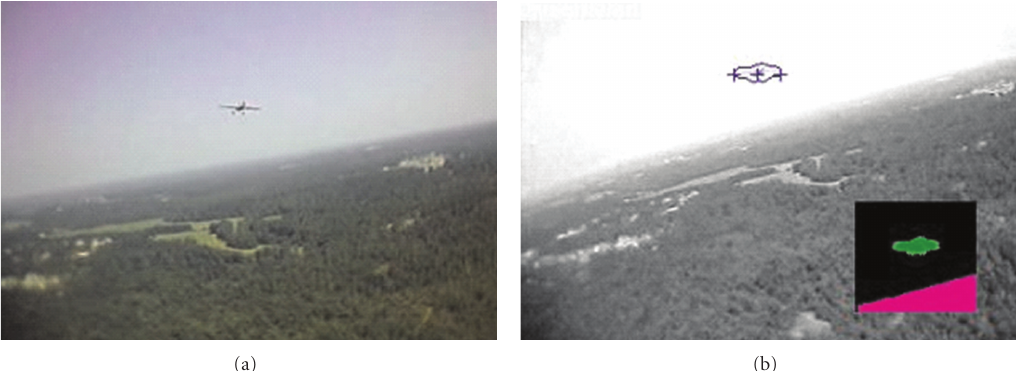
Figure 2: Image tracking result: (a) original image taken by the onboard camera, (b) center and two wing-tip positions of the leader airplane are